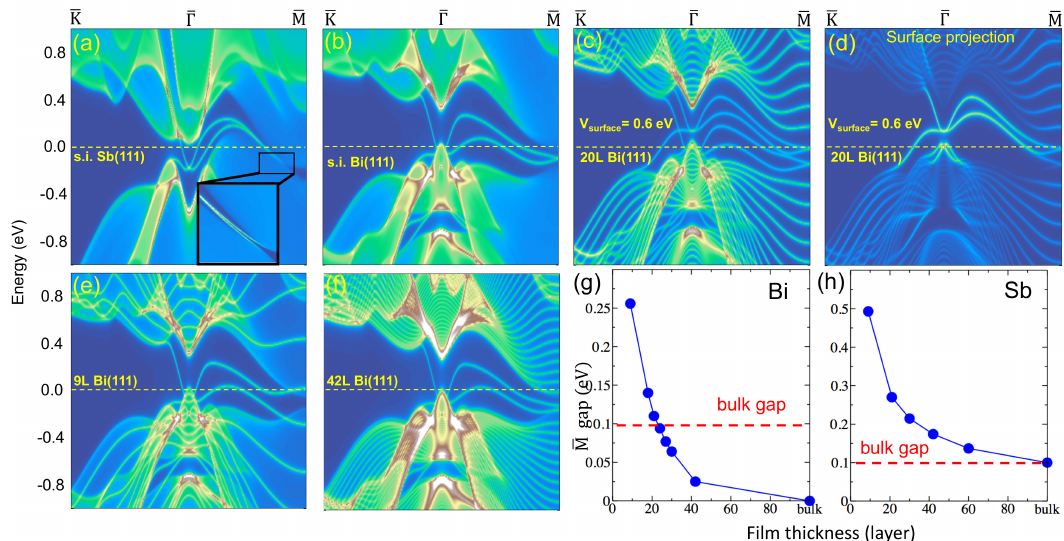
Figure 3. (Color online). ( a , b ) Band spectra of semi-infinite Bi and Sb crystals with a (111)-terminated surface. ( c ) Calculated band structure of 20L Bi(111) with a surface potential 0.6 eV on the top layer. ( d ) Same as ( c ) but weighted with the charge density at the top layer. ( e , f ) Band structure of 9L and 42L Bi(111) slabs. ( g ) The size of the band gap between the two surface bands at M as a function of Bi film thickness. ( h ) Same as ( g ), but for Sb films. The gap of Bi vanishes as the film thickness grows while the gap of Sb converges to the finite bulk gap value. This difference reflects the topology distinction between Bi and Sb band